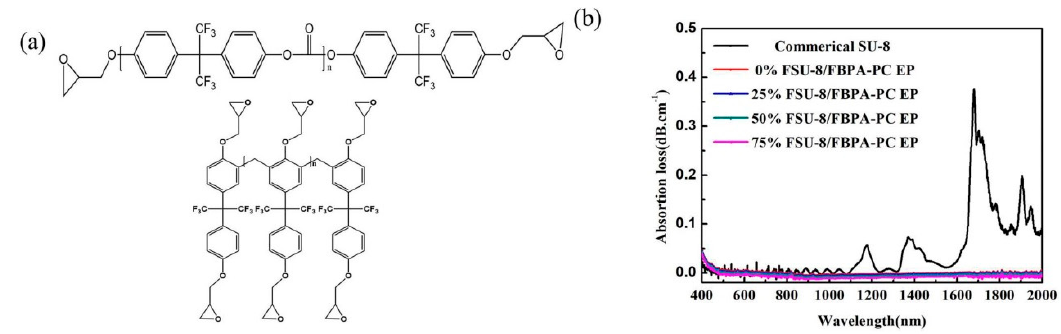
Figure 1. ( a ) Molecular structure of fluorinated photopolymer (FBPA-PC EP and FSU-8); ( b ) Near-